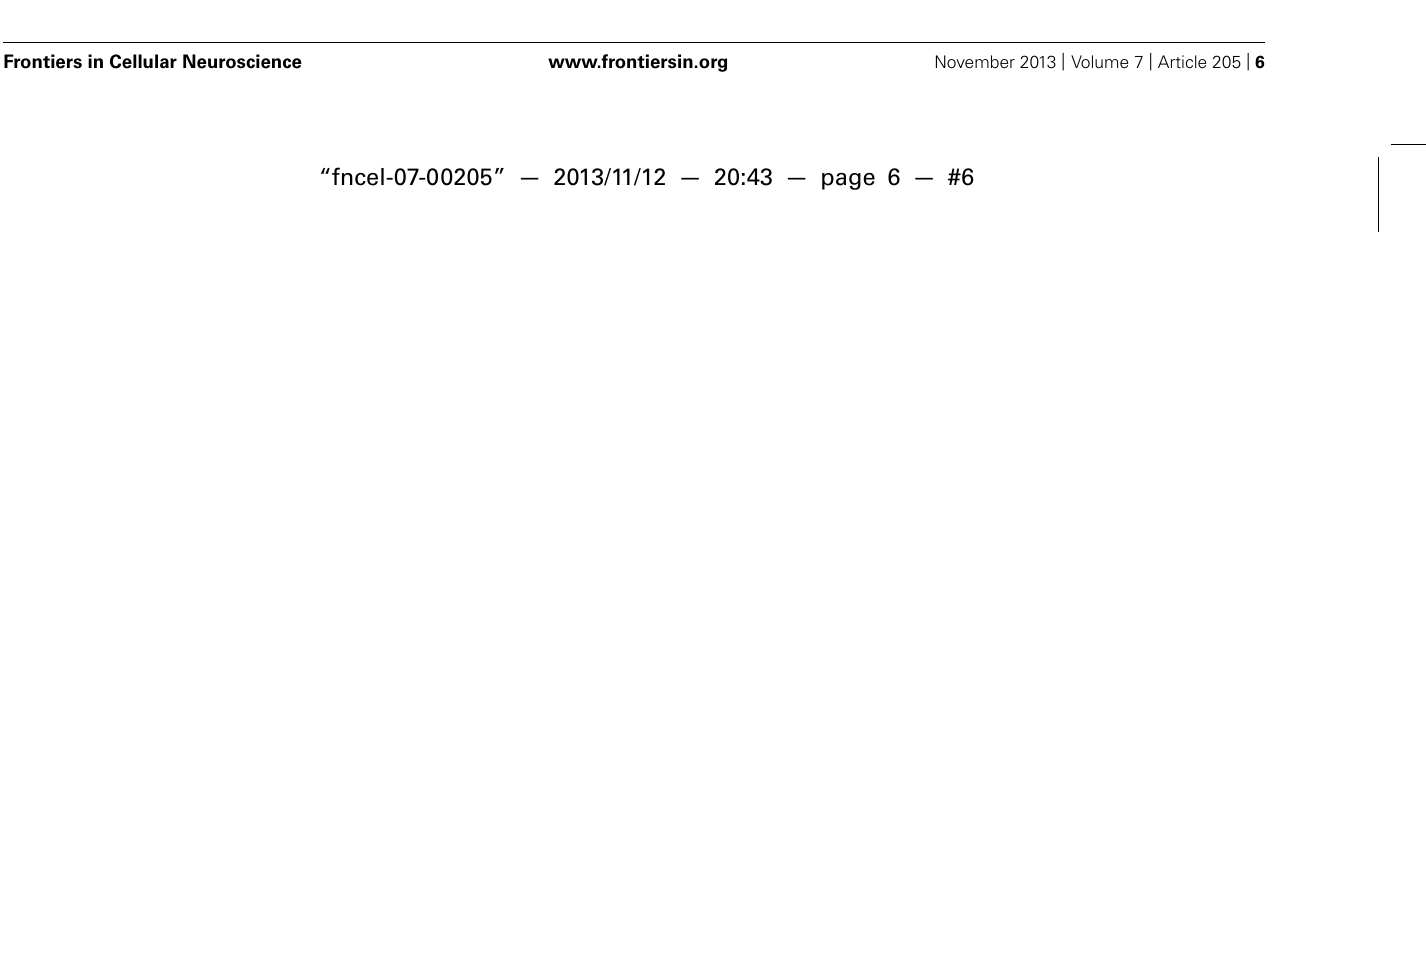
FIGURE 4 | Real time PCR data. (A) Normalization factor (NF) of each cell, calculated as the average expression of the two housekeeping genes compared to postnatal age. (B) NF of each cell compared to total cell capacitance (measured by 500 Hz sinus wave). (C) Relative quantity (RQ) of Kv3.3b versus postnatal age. (D) Normalized relative